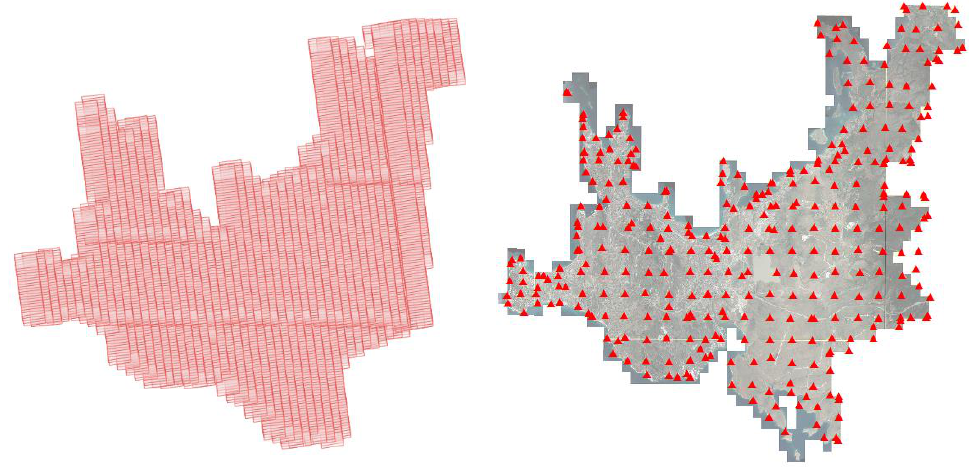
Figure 3. Aerial photogrammetric image block ( left ) and the GCP distribution ( right ) over the study area in Cesme, Izmir.